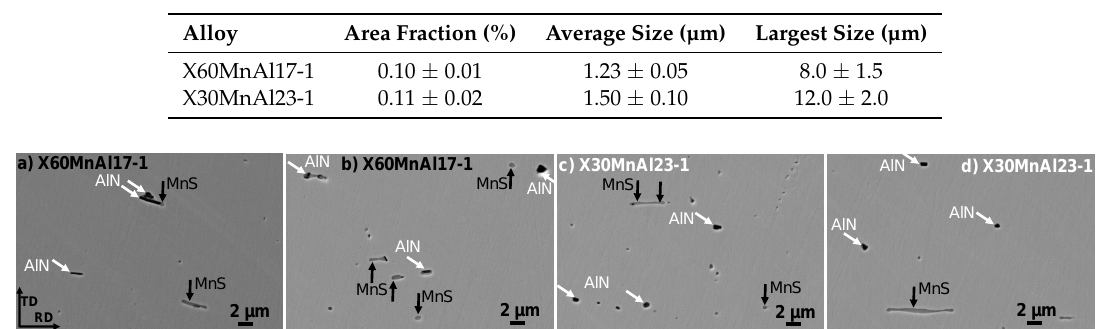
Table 2. Cleanliness analysis: area fraction, average and largest size of the inclusions. Size of the smallest inclusions found in both alloys is ∼ 0.5 µm. The scatter was estimated by analyzing four to five images taken at different locations.